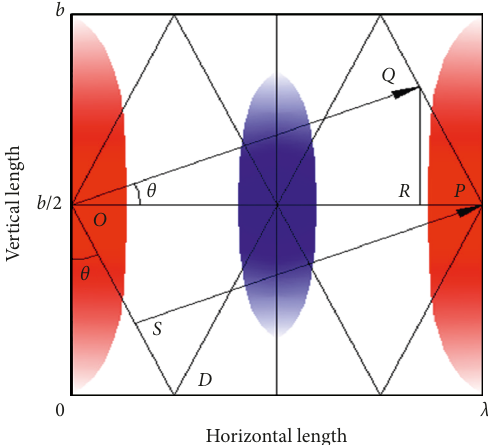
Figure 2: Fundamental wave formed by two intersected plane waves